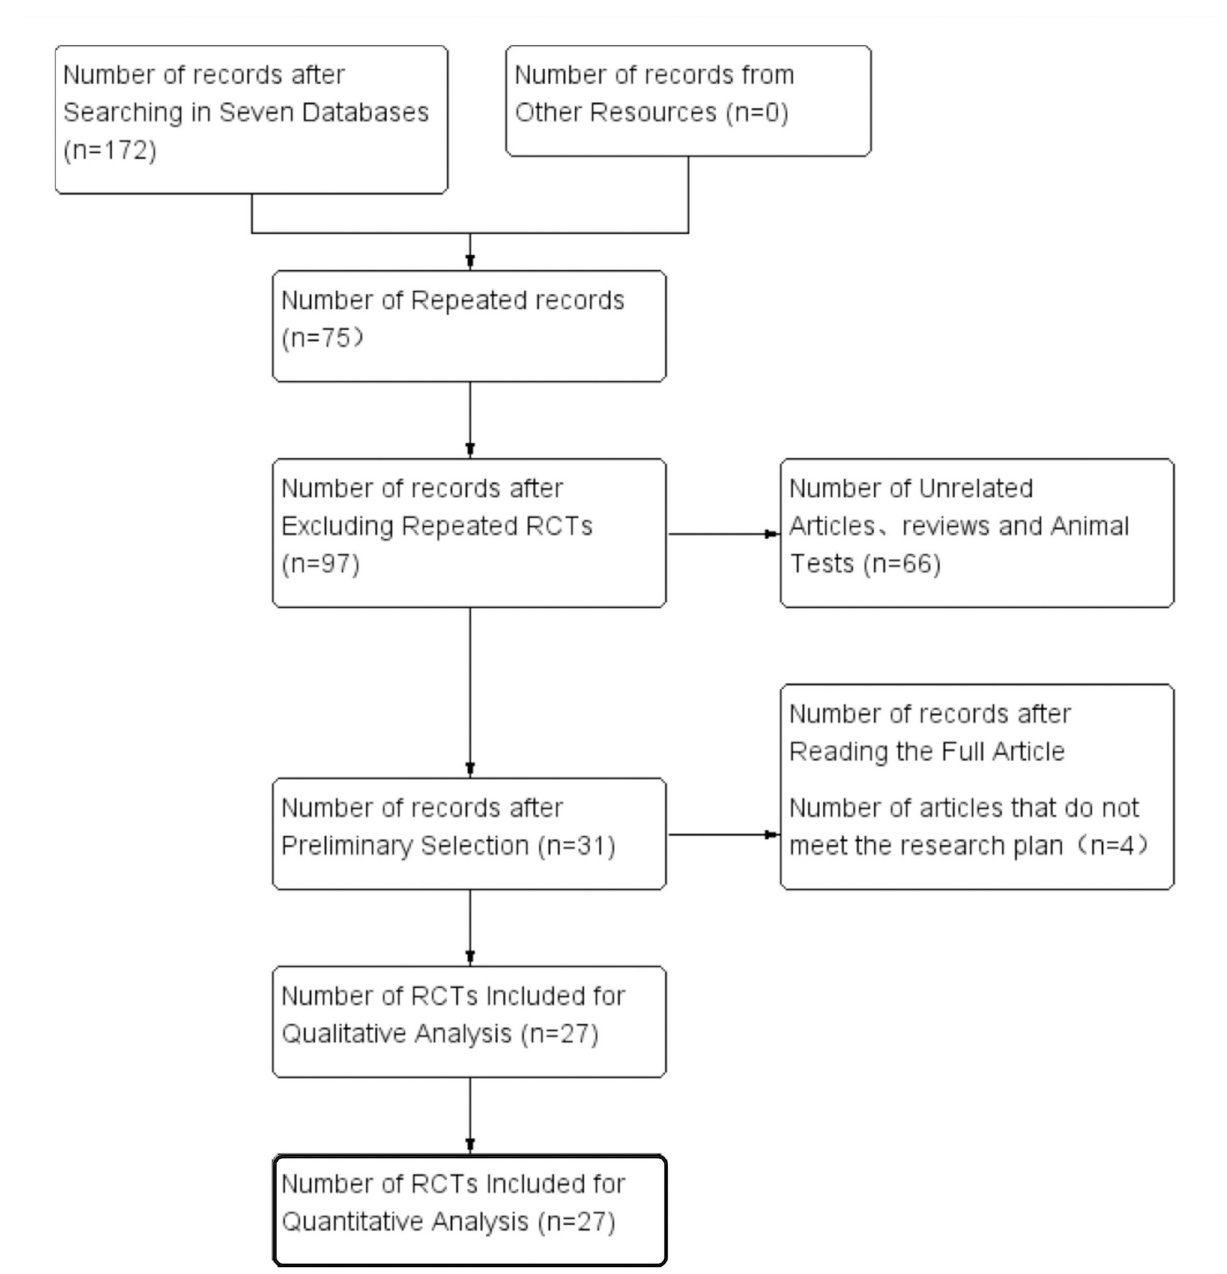
Fig 1. Flow chart of study